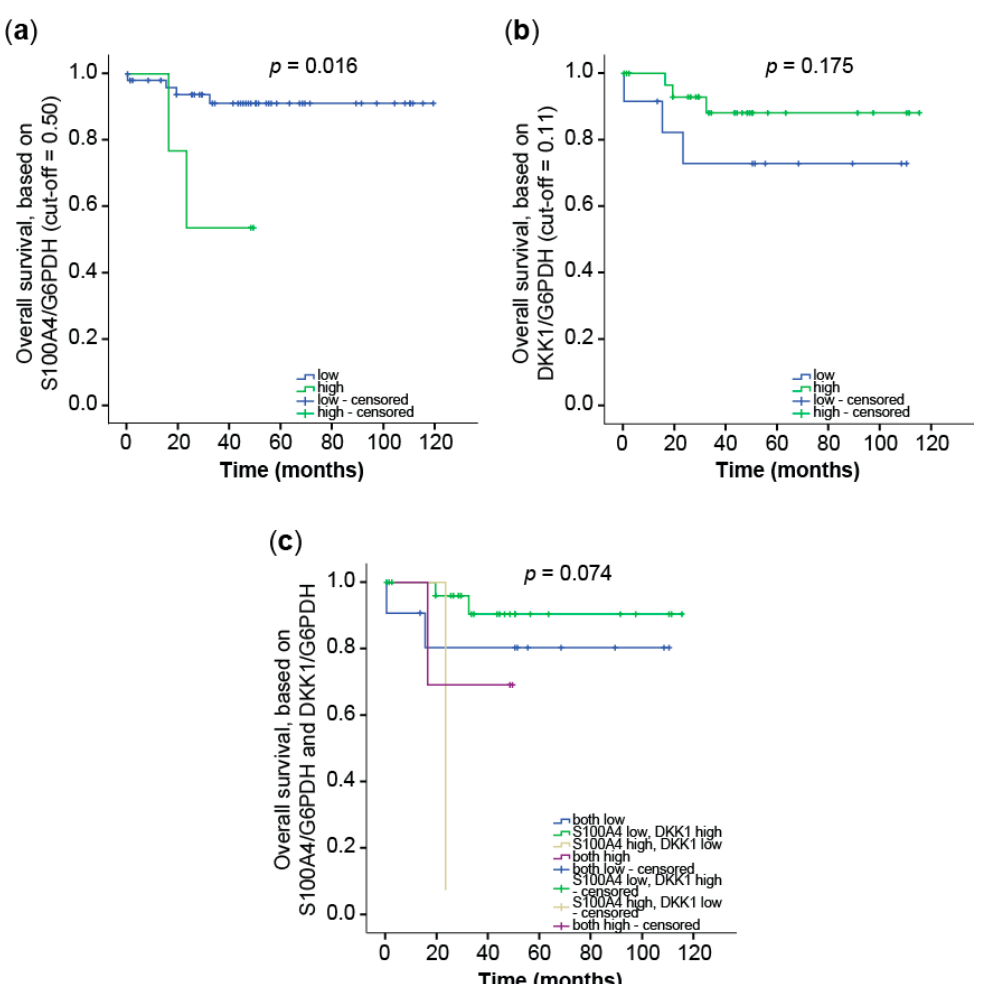
Figure 8. Combination of S100A4 and DKK1 for improved prognosis of OS CRC patients. DKK1, as well as S100A4, mRNA expression levels were determined by qRT PCR in micro-dissected tumor cell populations of primary tumors of stages I–IV ( n = 41). The cut-off values to distinguish low and high expression levels were determined by ROC analyses. ( a ) OS of CRC patients, based on the S100A4 mRNA expression in the primary tumor. ( b ) OS of CRC patients, based on the DKK1 mRNA expression in the primary tumor. ( c ) OS of CRC patients, based on the combination of S100A4 and DKK1 expression in the tumor. Cut-off values for the respective gene and analysis are indicated by the axis labels.